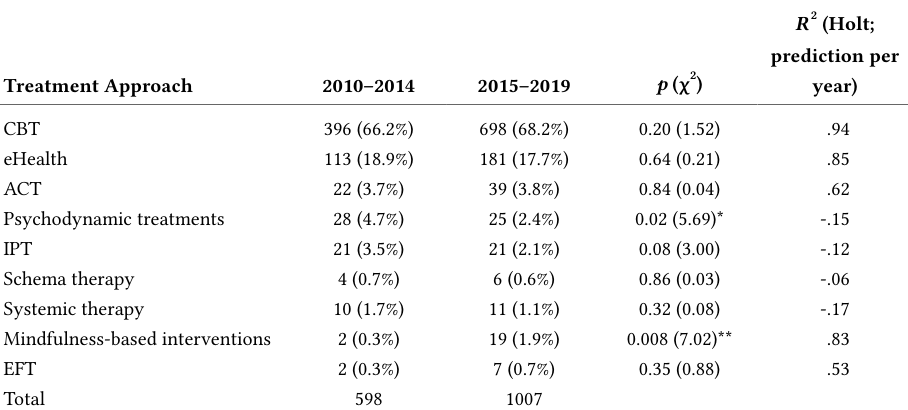
Treatment Arms in RCTs From 2010 to 2019 (Five-Year Blocks)